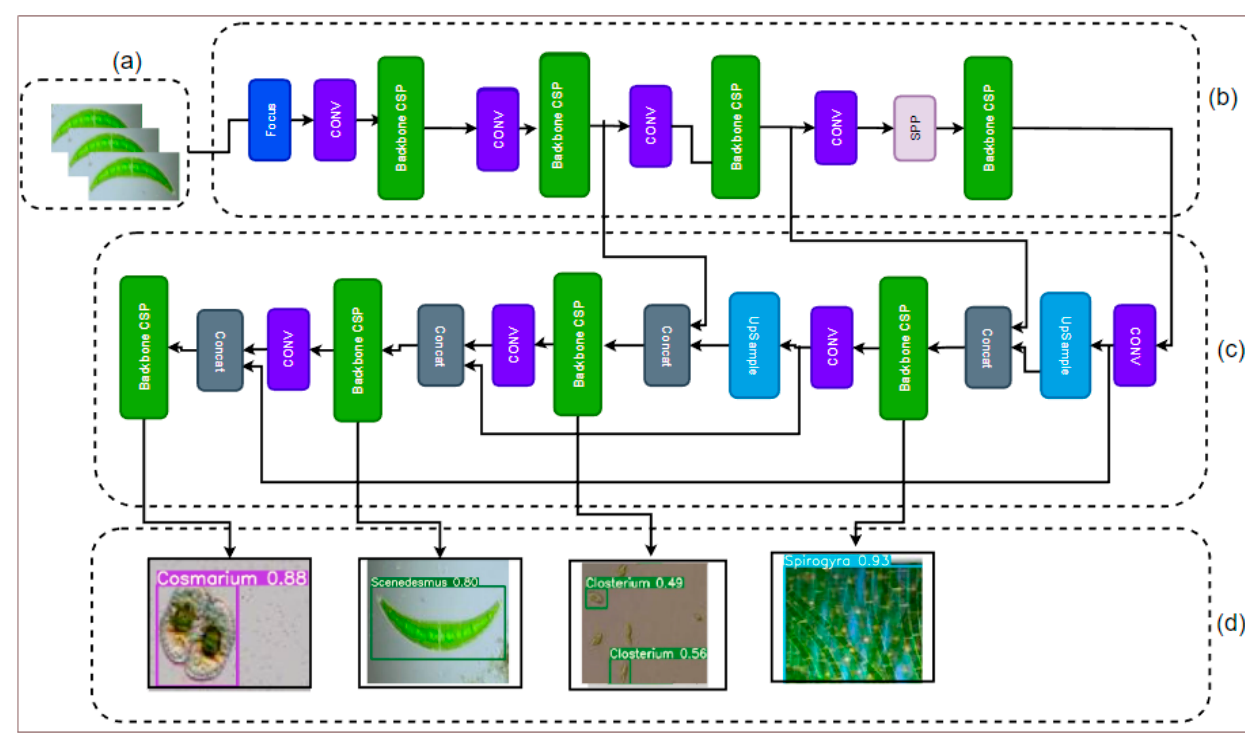
Figure 5. YOLOv5 architecture. ( a ) Input image, ( b ) backbone, ( c ) neck and ( d ) detection.